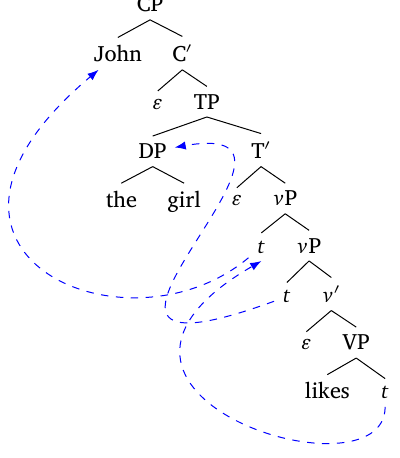
MG phrase structure tree for John, the girl likes ; dashed arrows indicate